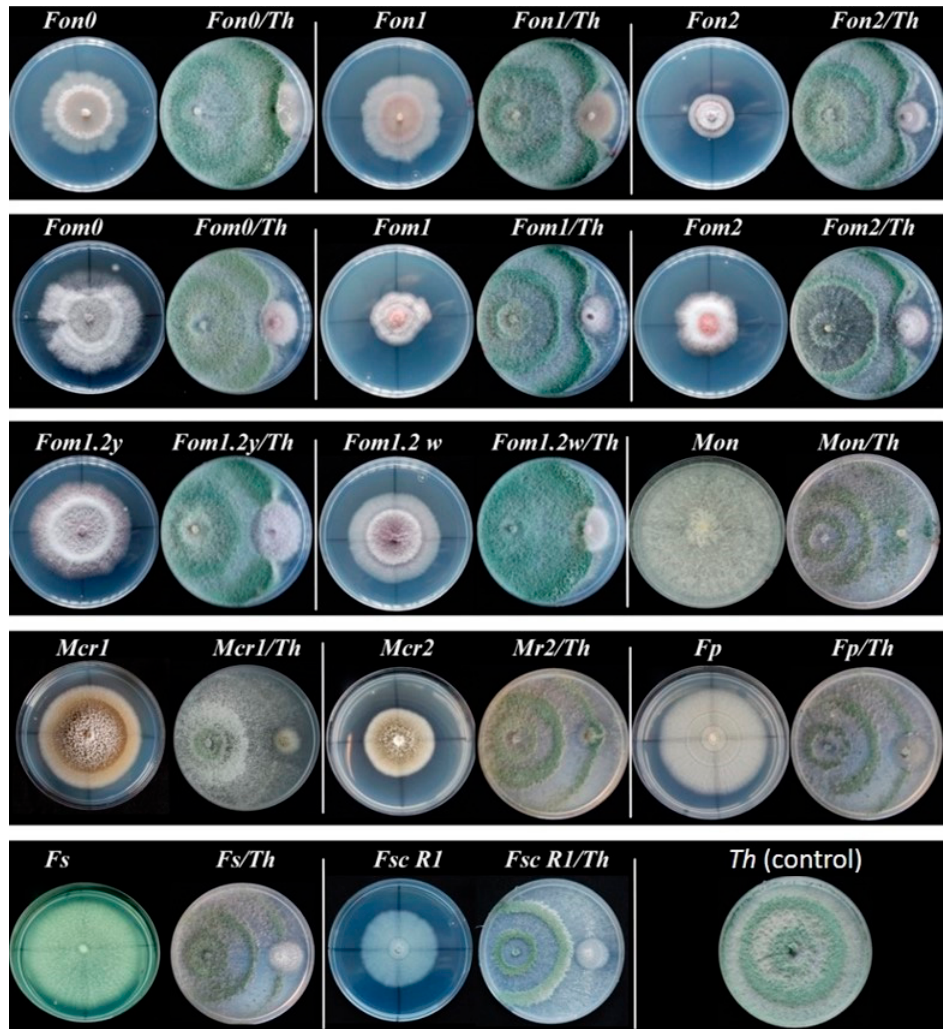
Figure 2. Growth inhibition effects of Trichoderma harzianum ( Th ) against 14 selected pathogens. From left to right there is a pathogen control plate followed by the dual culture plate (pathogen/ T. harzianum ).